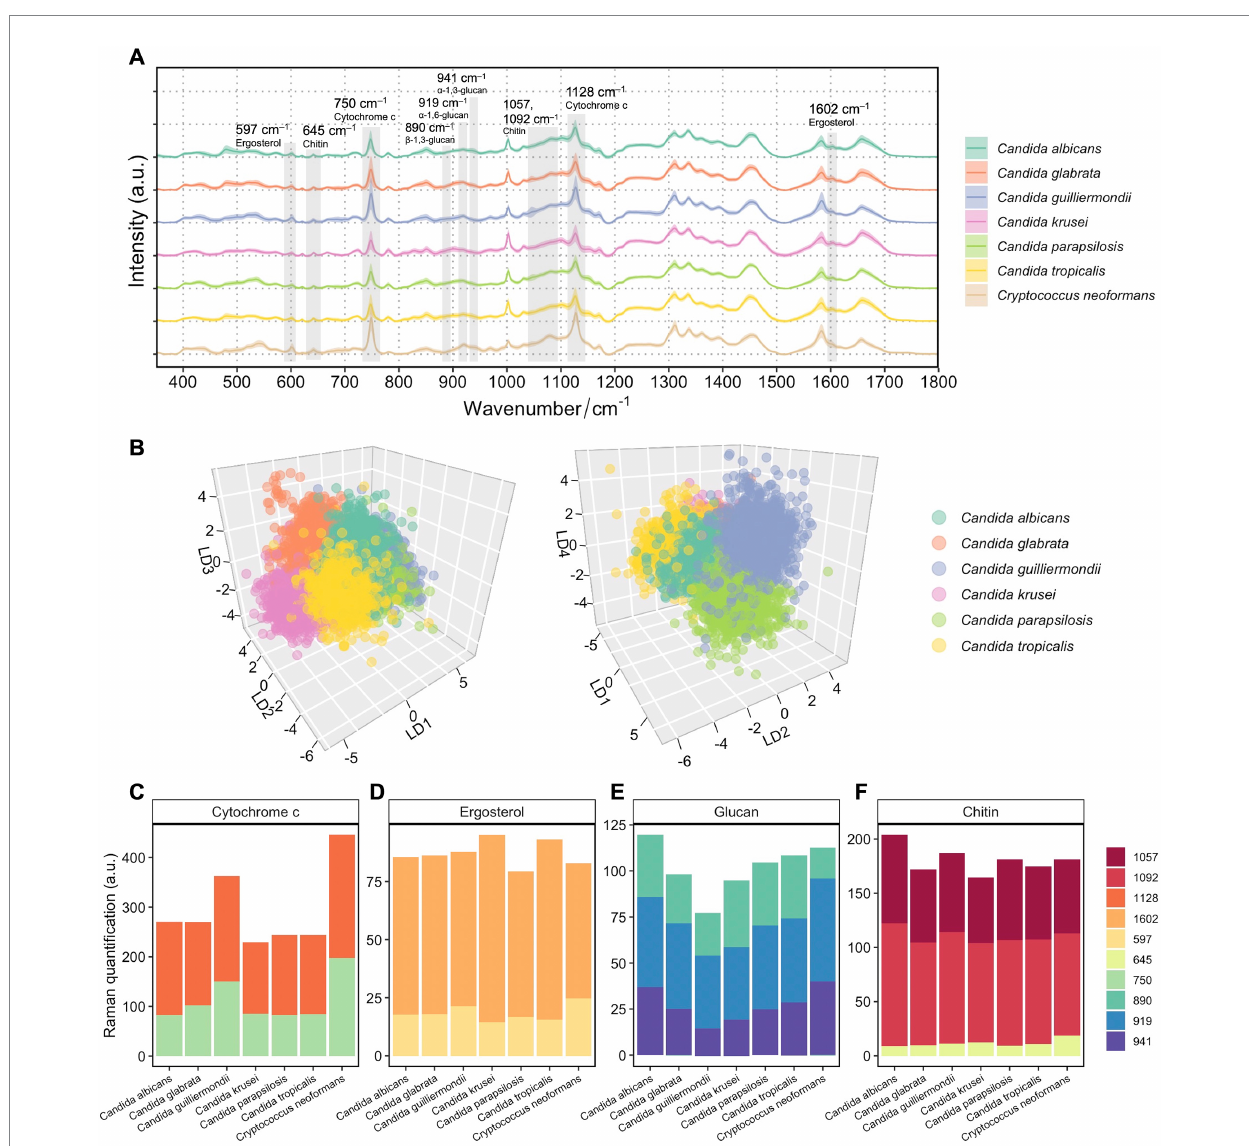
FIGURE 2 Spectroscopic characterization of 7 fungal species from 94 patients’ isolates. (A) Averaged Raman spectra of 94 clinical isolates from 7 fungal species, each isolate averaged from over 1,000 spectra ( n = 115,129 in total). Shaded area represents standard deviation from single-cell measurements. Biological assignments of Raman bands contributing mostly to the differentiation between different fungal species are highlighted. (B) Supervised LDA visualization of single fungal cells based on their Raman spectra. A 3D plot with LD1, LD2, and LD3 shows distinct clusters of Candida albicans , Candida glabrata , Candida krusei , and Candida tropicalis (left). A 3D plot with LD1, LD2, and LD4 shows additional separations between clusters of Candida guilliermondii and Candida parapsilosis (right). (C) Quantification of cytochromes in 7 fungal species by integrating Raman bands at 750 and 1,127 cm − 1 . (D) Quantification of ergosterol in 7 fungal species by integrating Raman bands at 540 and 1,602 cm − 1 . (E) Quantification of glucans in 7 fungal species by integrating Raman bands at 890, 919 and 941 cm − 1 . (F) Quantification of chitin in 7 fungal species by integrating Raman bands at 645, 1050, and 1,090 cm − 1